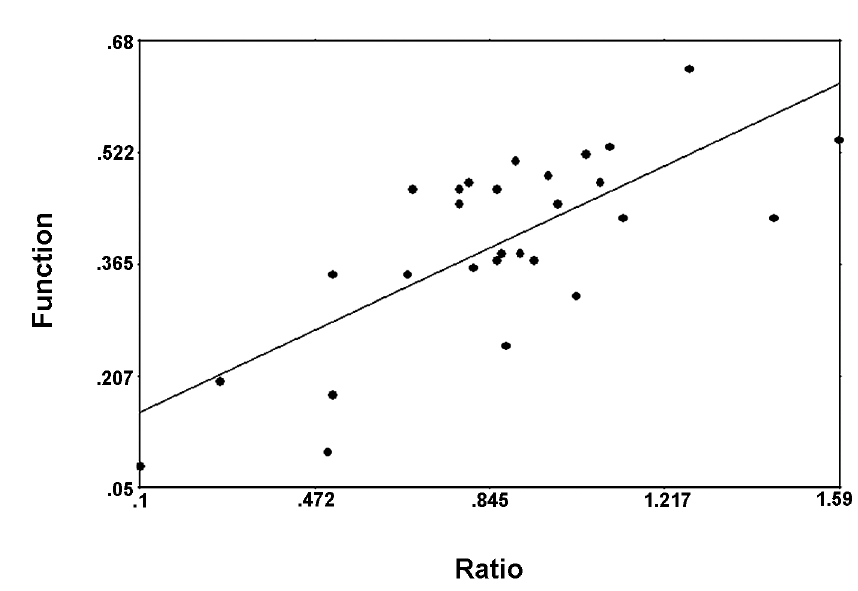
Figure 2 – Linear regression showing renal parenchyma thickness ratio vs. renogram